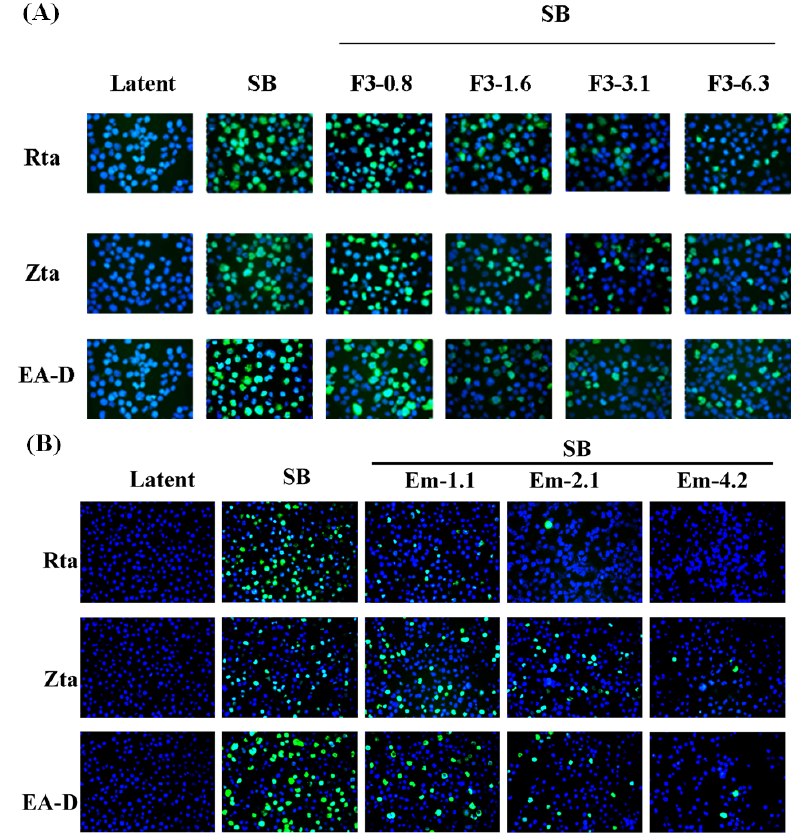
Figure 4. Indirect immunofluorescence analysis of inhibition of the expressions of EBV lytic genes by F3 and emodin. P3HR1 cells were pre-treated with F3 (0.8, 1.6, 3.1 and 6.3 μ g/mL) ( A ) or emodin (1.1, 2.1 and 4.2 μ g/mL) ( B ) before lytic induction for 24